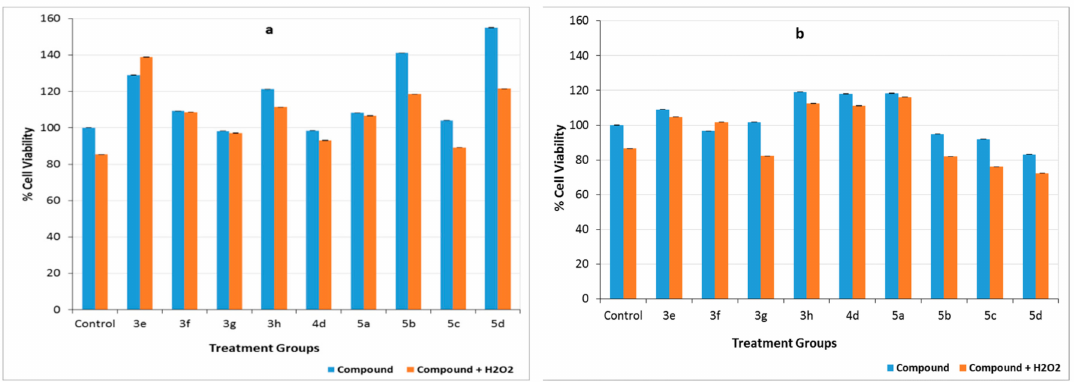
Figure 5. H 2 O 2 -induced cell death protective e ff ects of compounds ( a ) in cancerous A431 and ( b ) in noncancerous HaCaT cell